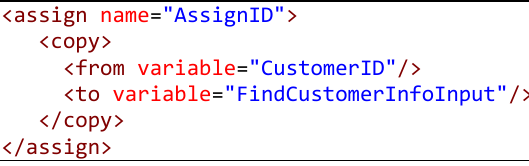
Fig. 10. Constructor of an Assign Activity